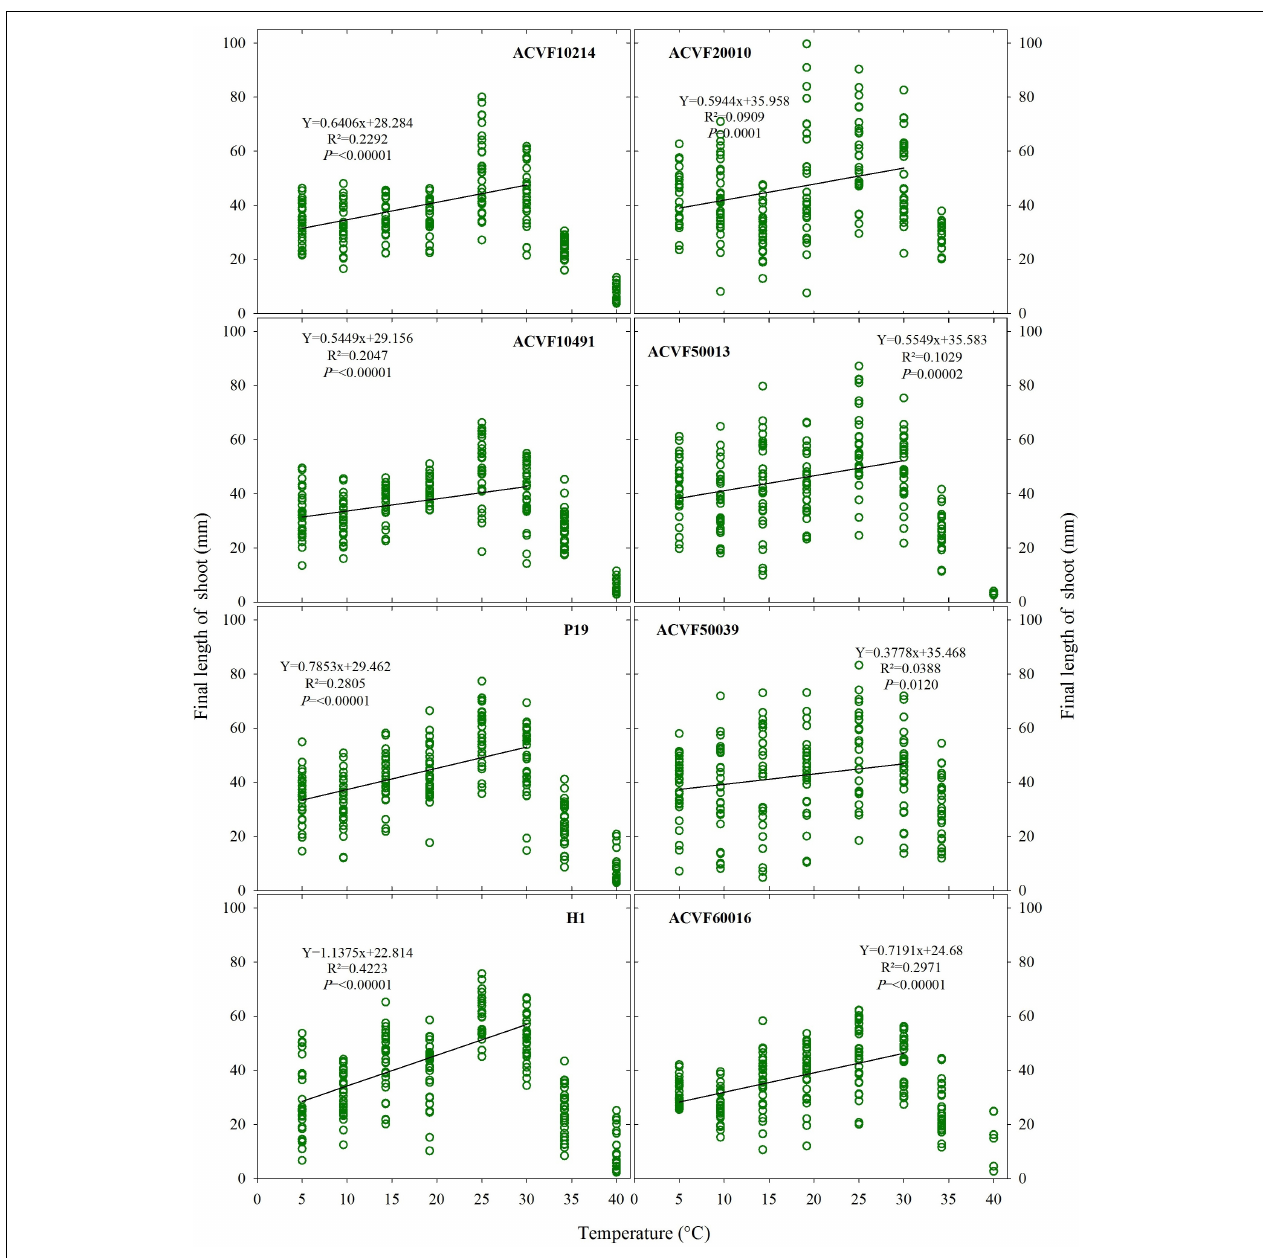
FIGURE 6 | The final length of shoot for the eight accessions of Lolium perenne during heterotrophic growth in response to a constant temperature. For each temperature between 5 and 35 ◦ C, n = 30. For 40 ◦ C, 0 ≤ n ≤ 30 because of seedling mortality.